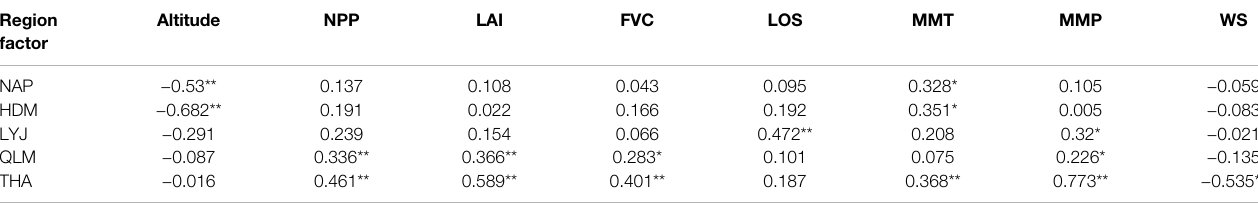
TABLE 1 | Values of r for the partial correlation analysis between oxygen content and altitude, climate, and vegetation factors in different regions. Region factor